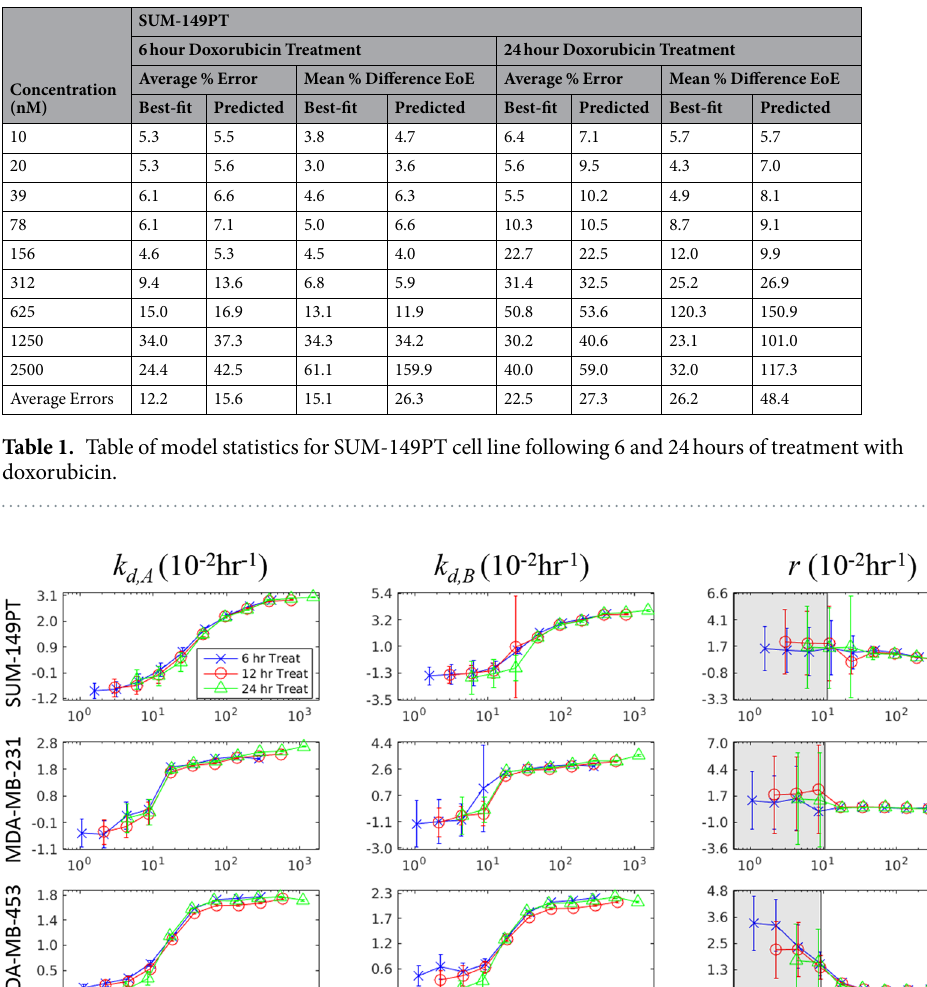
(meaning that other parameters account for 70% of model variation in this range).